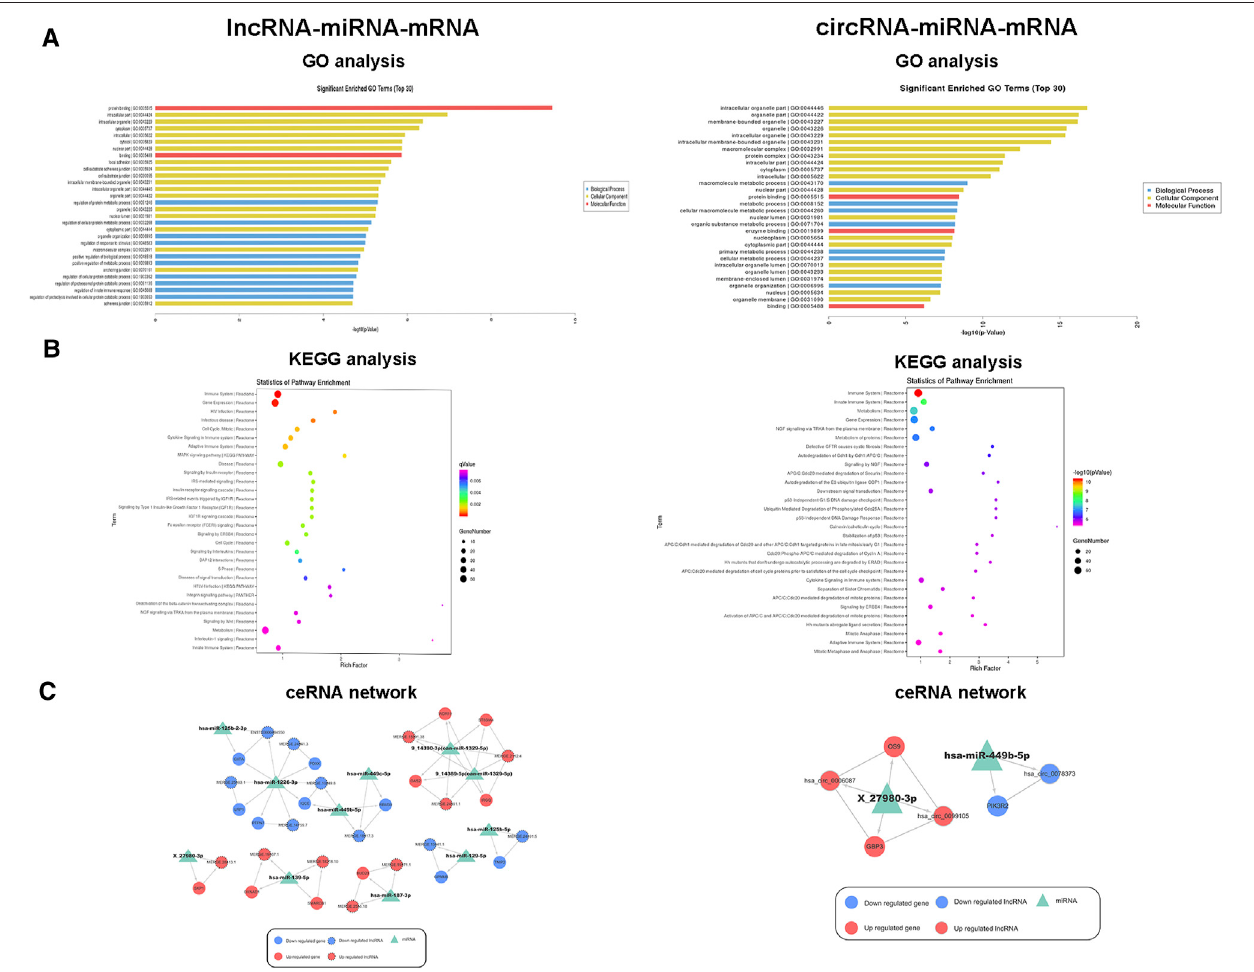
FIGURE4| FunctionalanalysisandceRNAnetworkofDEncRNAsandmRNAs. (A) Top30termsfromaGOanalysisofDEmRNAsrelatedtolncRNA-miRNAand circRNA-miRNA pairs. (B) KEGG pathway analysis of DE mRNAs and the top 30 pathways. (C) lncRNA-miRNA-mRNA and circRNA-miRNA-mRNA ceRNA networks. ThetriangleindicatesamiRNA,thecirclerepresentsanmRNA,thecircleandtheoutergraycirclerepresentalncRNAorcircRNA,redandblueindicateupregulationand downregulation, respectively, and green indicates unknown.